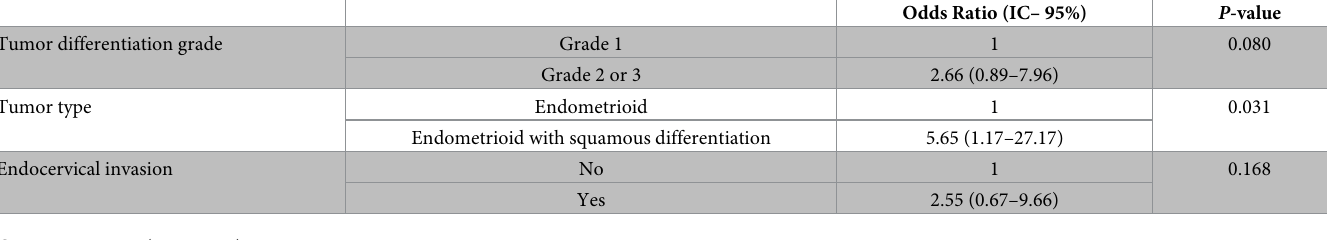
Odds Ratio (IC– 95%) P -value